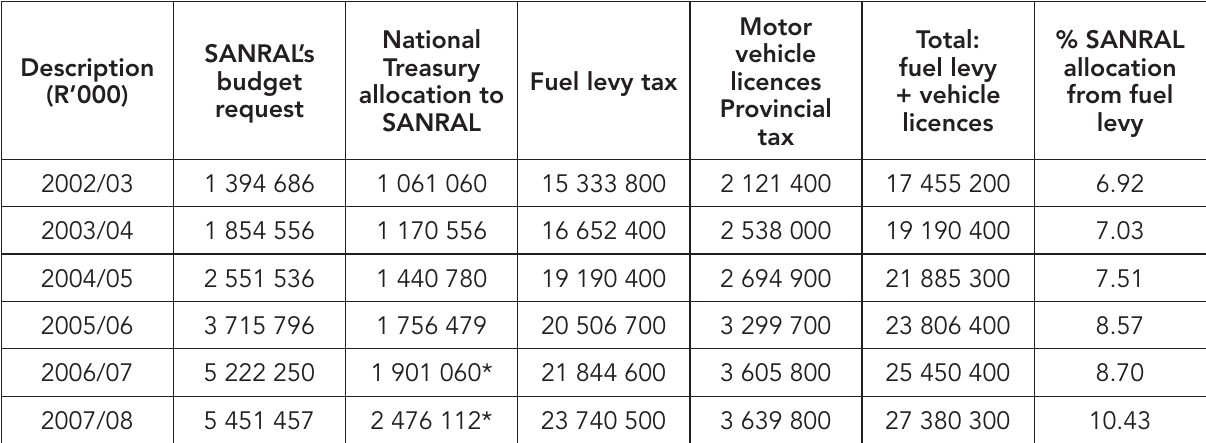
Table I: National Treasury allocation to SANRAL versus fuel levy tax and vehicle